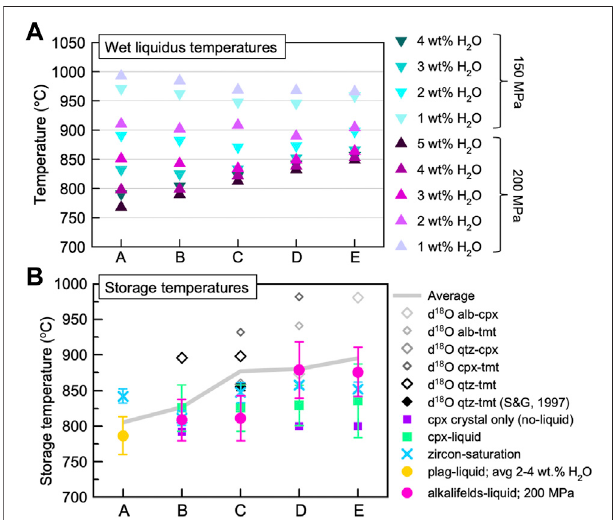
FIGURE 8 | Calculated temperatures for Rattlesnake Tuff (RST) high- silicarhyolites. (A) Wetliquidustemperaturesat200and150 MPaandvarious water contents were determined using Rhyolite-MELTS software (Gualda et al., 2012). (B) Crystal-liquid and zircon saturation storage temperatures were calculated using equations from Putirka (2008). The clinopyroxene (cpx crystal only) temperatures were calculated using a geothermometer and R script developed by Jorgenson et al. (2021). δ 18 O temperatures were calculated using coef fi cients and equations from Chiba et al. (1989). Group A is considered aphyric, but a plagioclase-liquid temperature was calculated using the composition of one plagioclase grain from Streck and Grunder (1997). Calculated zircon-saturation maximum temperaturesarereportedforGroupsB-Ebecausetheyareknowntocontain zircon, and a minimum is used for Group A because presence of zircon within GroupAisnot known. Alkali feldspar-liquid temperatures are used forGroups A-E because Streck and Grunder (1997) reported these Groups contained Na-sanidine to anorthoclase composition feldspars. Groups B-E contain clinopyroxene and titanomagnetite that were analyzed for oxygen isotopes. Group E titanomagnetite produced an anomalously high δ 18 O and subsequent clinopyroxene-titanomagnetite (cpx-tmt) temperature of ~1300 ° C, so this temperature is considered erroneous and is not included here. See Table 3 for all plotted temperatures and Table 4 for all oxygen isotope